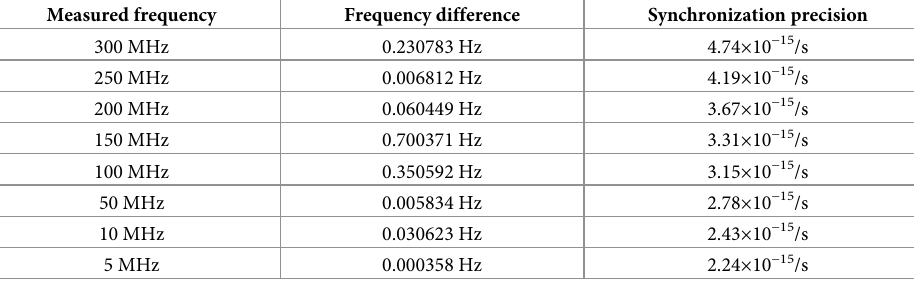
Table 1. Frequency synchronization detection results with the same